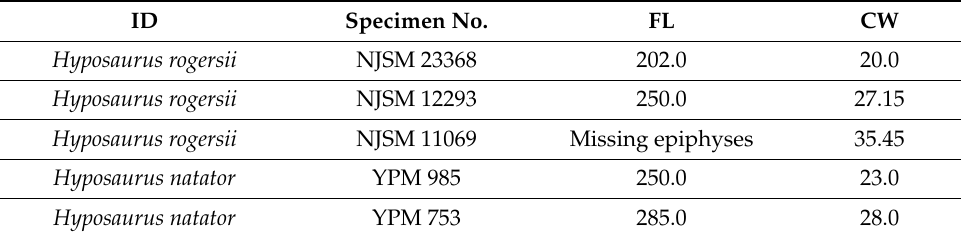
Table 3. Femoral length and corpus width of selected Hyposaurus femora in mm. NJSM = New Jersey State Museum. YPM = Yale Peabody Museum. FL = Femoral length, distance from the most proximal point on the proximal articular surface of the bone to the most distal point on the lateral distal condyle. CW = Corpus width, the minimum width at the